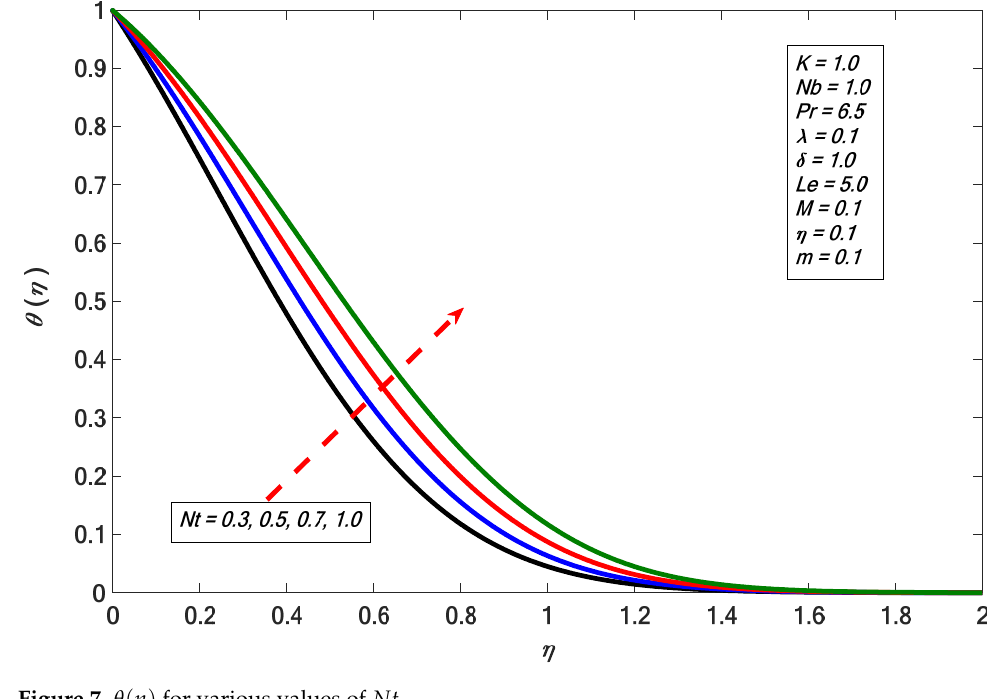
Figure 7. 𝜃(cid:4666)𝜂(cid:4667) for various values of 𝑁𝑡. Figure 7. θ ( η ) for various values of Nt .